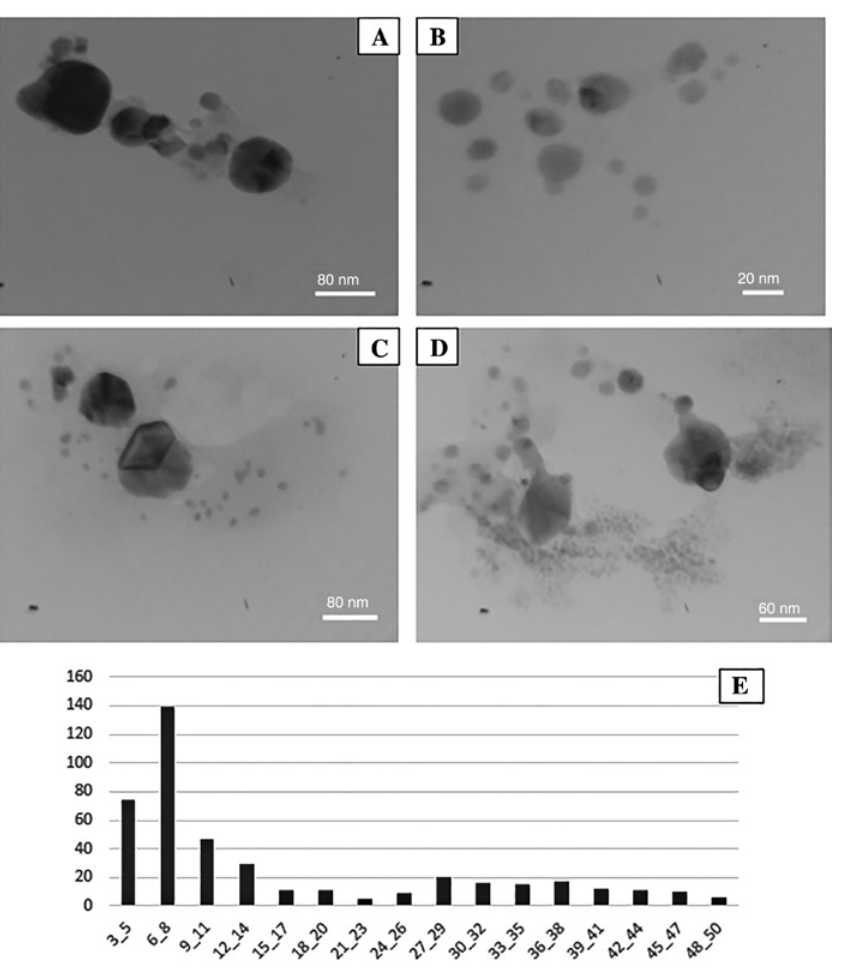
Figure 3: (A–D) The transmission electron microscopy (TEM) images of silver nanoparticles (AgNPs). (E) Histogram of particle size distribu- tion of AgNPs.